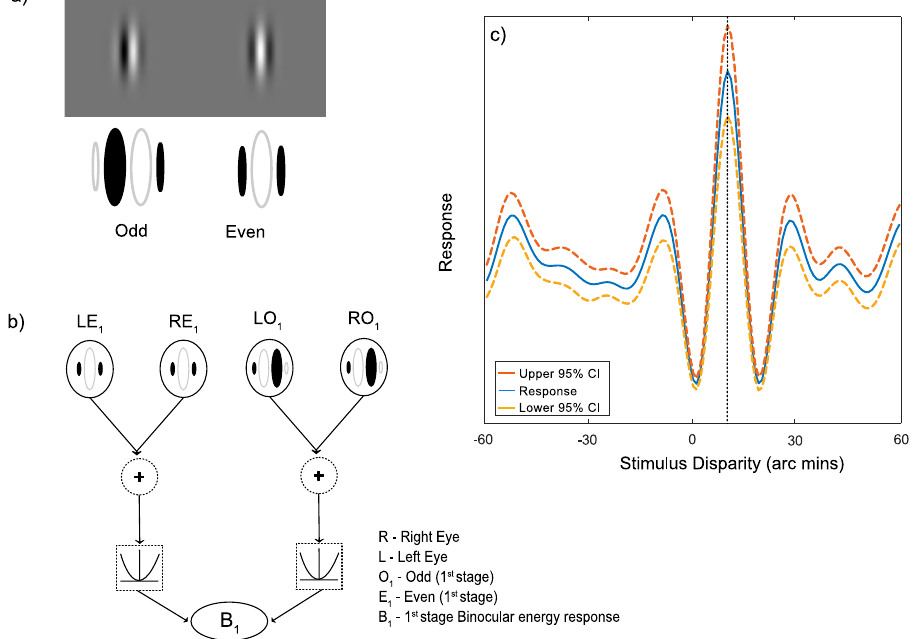
Figure 1. ( a ) Odd and even symmetric monocular receptive fields ( b ) These receptive fields are combined to compute the binocular energy response ( c ) The responses of binocular energy neurons show a characteristic tuning function. Here the response, calculated as the mean over 1000 Gaussian white noise samples, shows a peak at the disparity (10 arc min) corresponding to the difference in position of the monocular receptive fields. Dotted lines show upper and lower 95% confidence